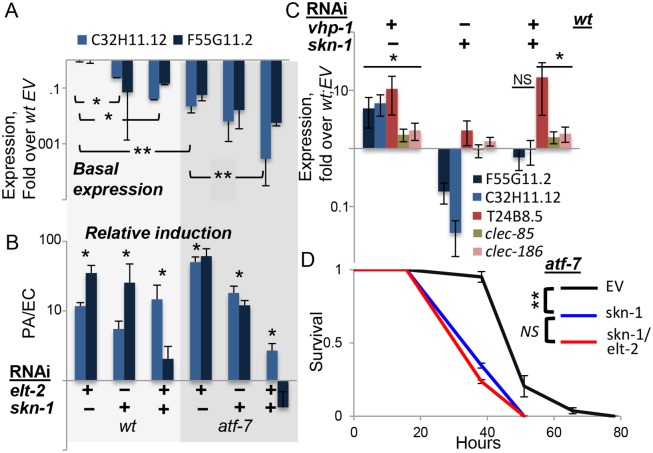

skn-1 co-regulates gene expression with atf-7 and elt-2.
A-C, Gene expression (log scale) in wildtype or atf-7(qd22qd130) animals fed with designated RNAi’s during development. Averages ± SDs for two independent experiments (or three, in C), with *p<0.05 and **p<0.0005 (t-test) for differences between groups joined by line (A), or between marked groups and their respective references (B). A, basal expression following development knock-down, with values and statistics relative to values in wt;EV, not shown. B, similar RNAi treatments as in A, followed by exposure to P. aeruginosa (PA). Responses to PA are shown as fold over basal expression in similarly-treated worms grown on E. coli (EC). C, basal expression following development knock-down; note effective induction of T24B8.5, clec-85 and clec-186 by vhp-1 RNAi in the context of a double knock-down. D, Survival curves for atf-7(qd22qd130) animals fed with designated RNAi’s during development, followed by infection; averages ± SDs for three plates (N = 83–90 per group).